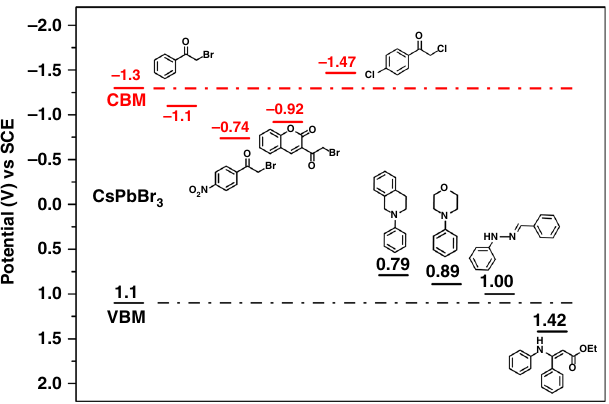
Fig. 4 Band energy of CsPbBr 3 vs the redox potentials of substrates. Source data are provided as a Source Data fi